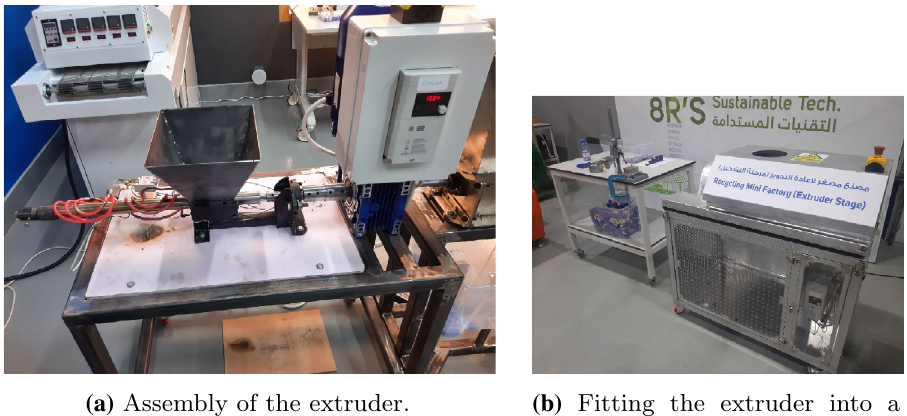
Fig. 12 Fabrication of the extrusion machine